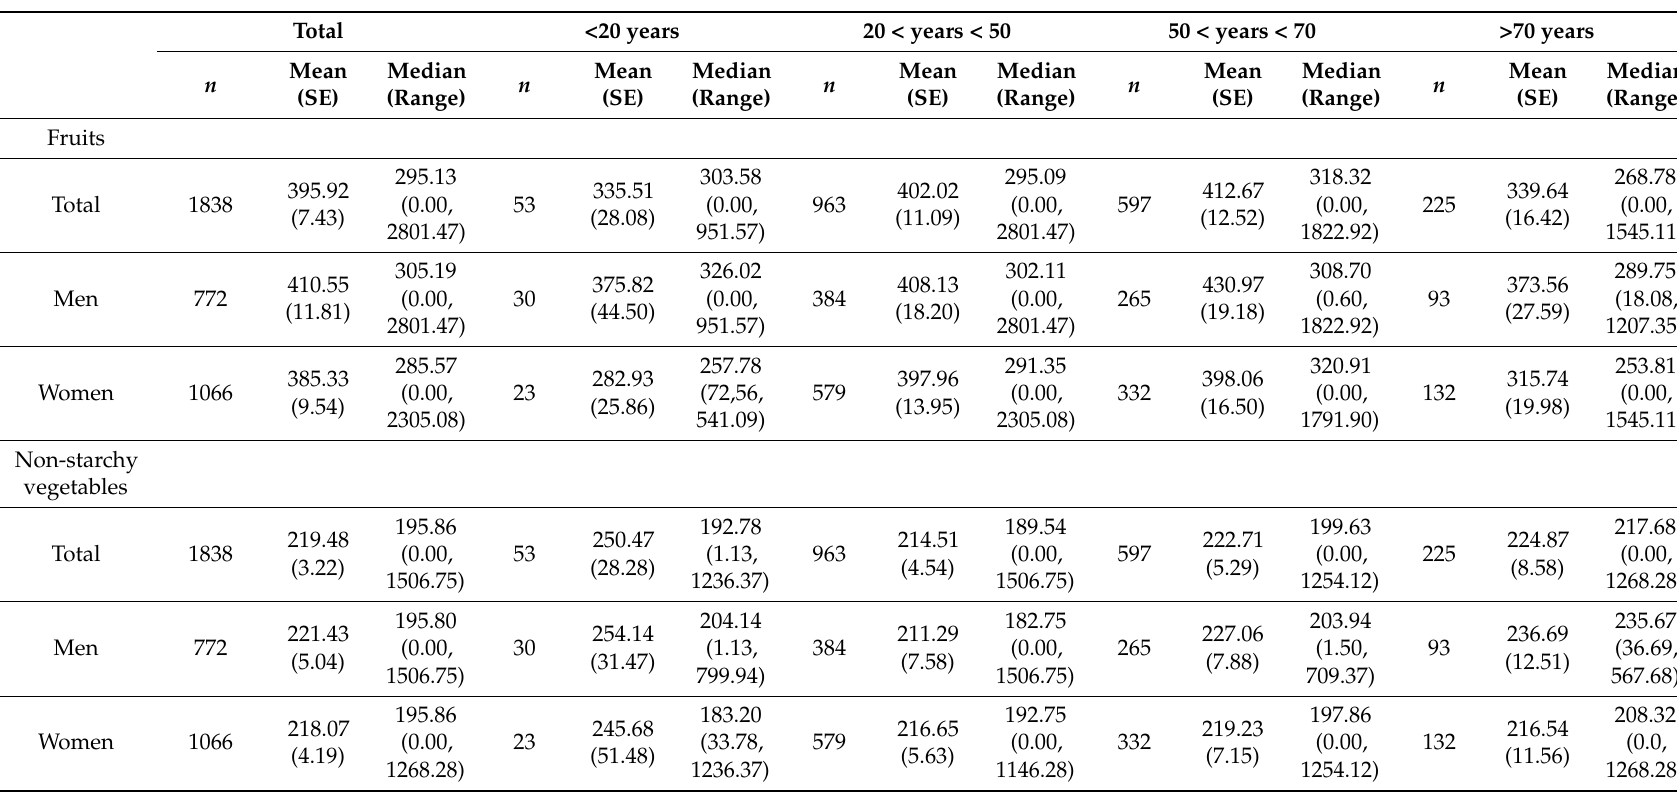
Table 3. Total, sex, and age group-specific consumption of plant food groups in the study participants of the MEAL study ( n = 1838). * denotes p <